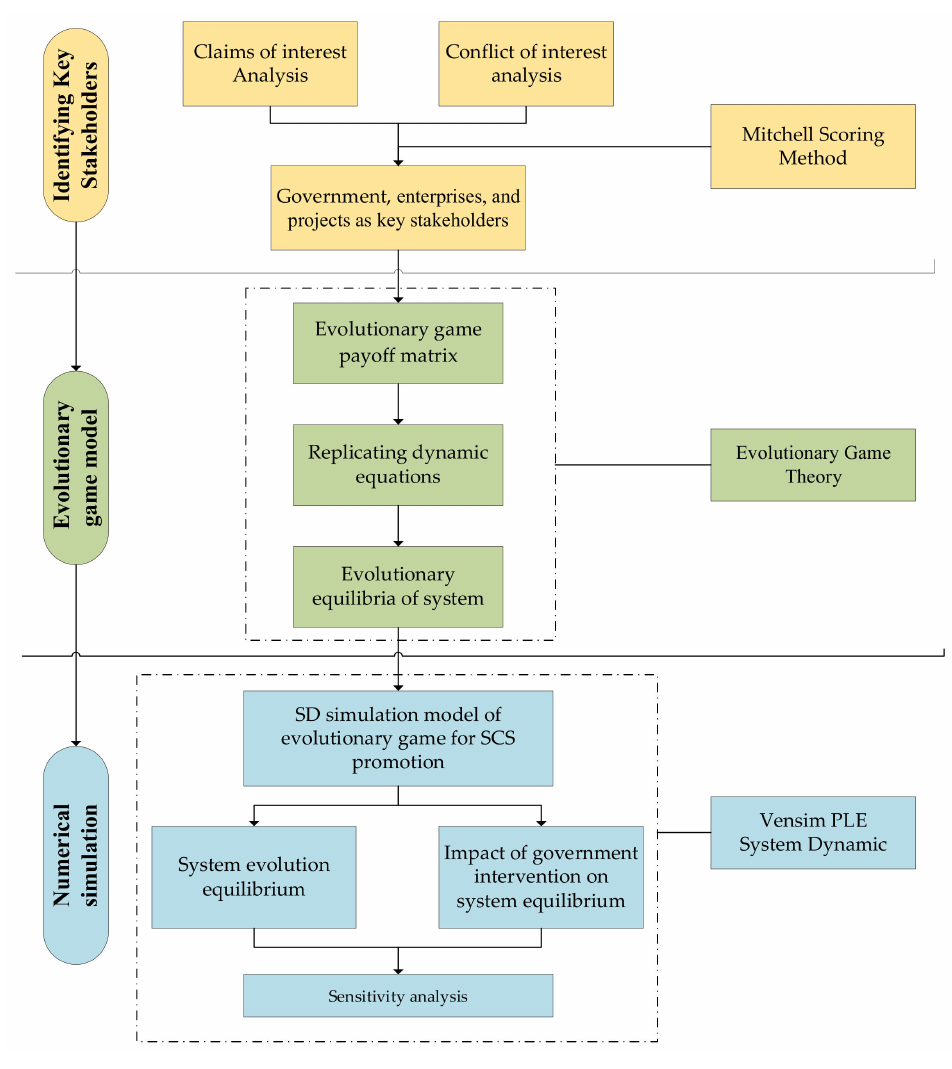
Figure 1. Research Methodology. Table 1. Glossary of